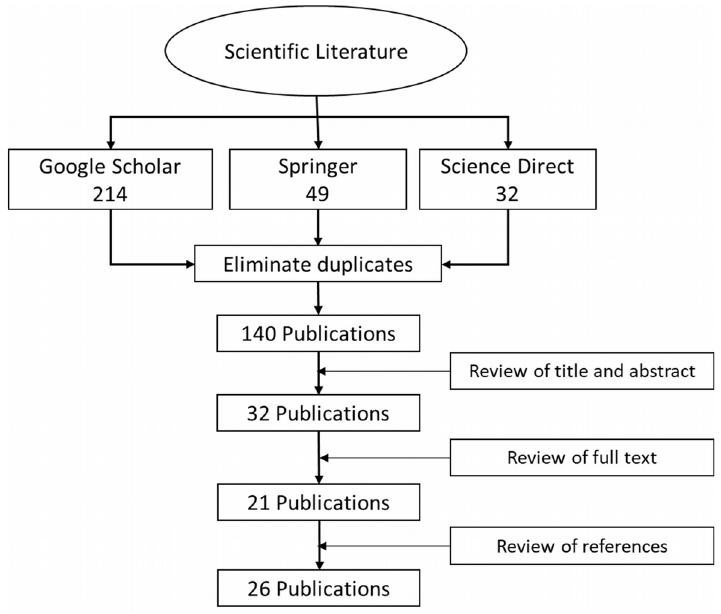
Figure 1. Flow chart of the research